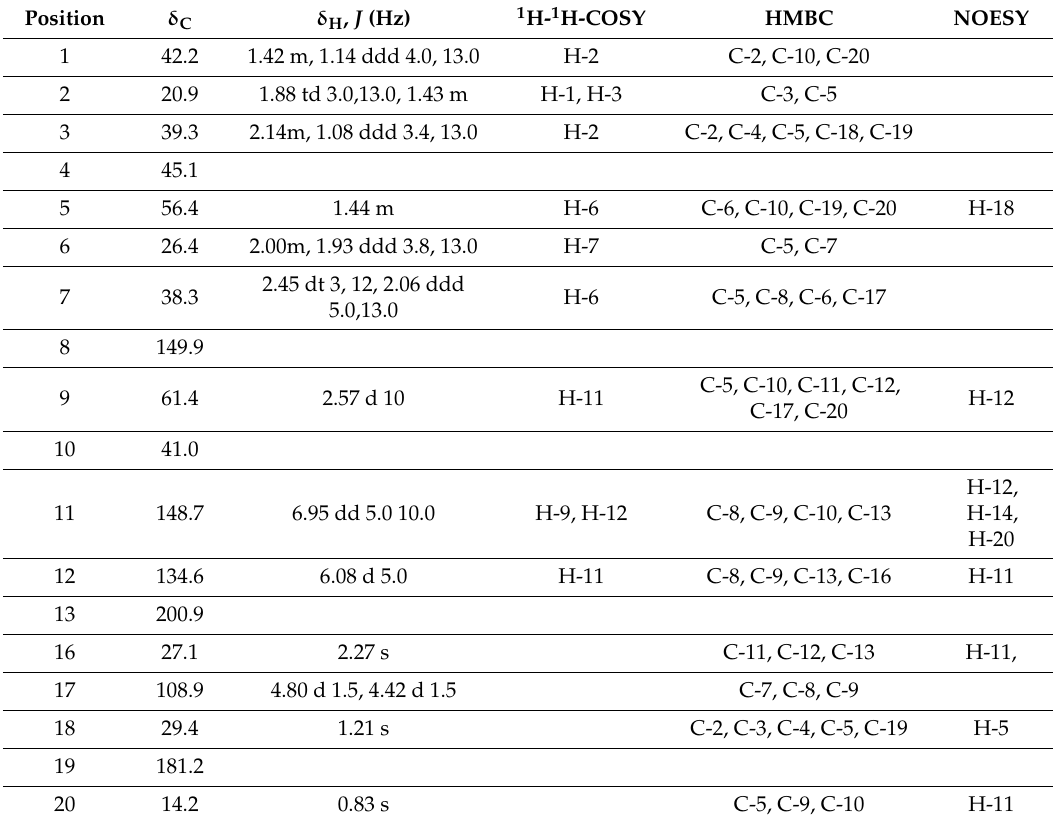
Table 1. NMR spectroscopic data for compound 1 acquired in CD 3